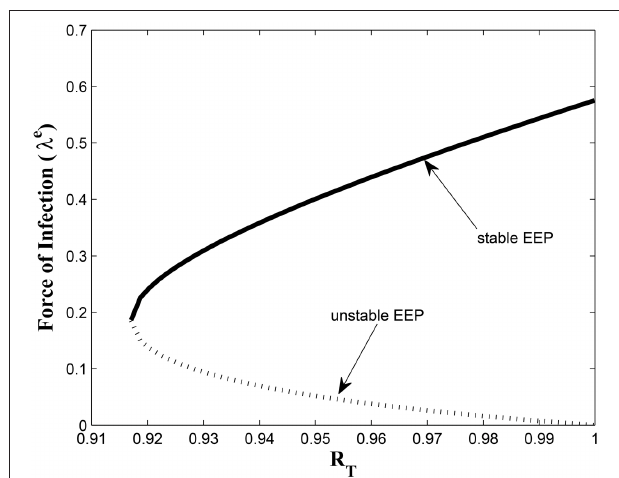
FIGURE 5 | Backward bifurcation when b 1 6= 0 and b 2 6= 0 .